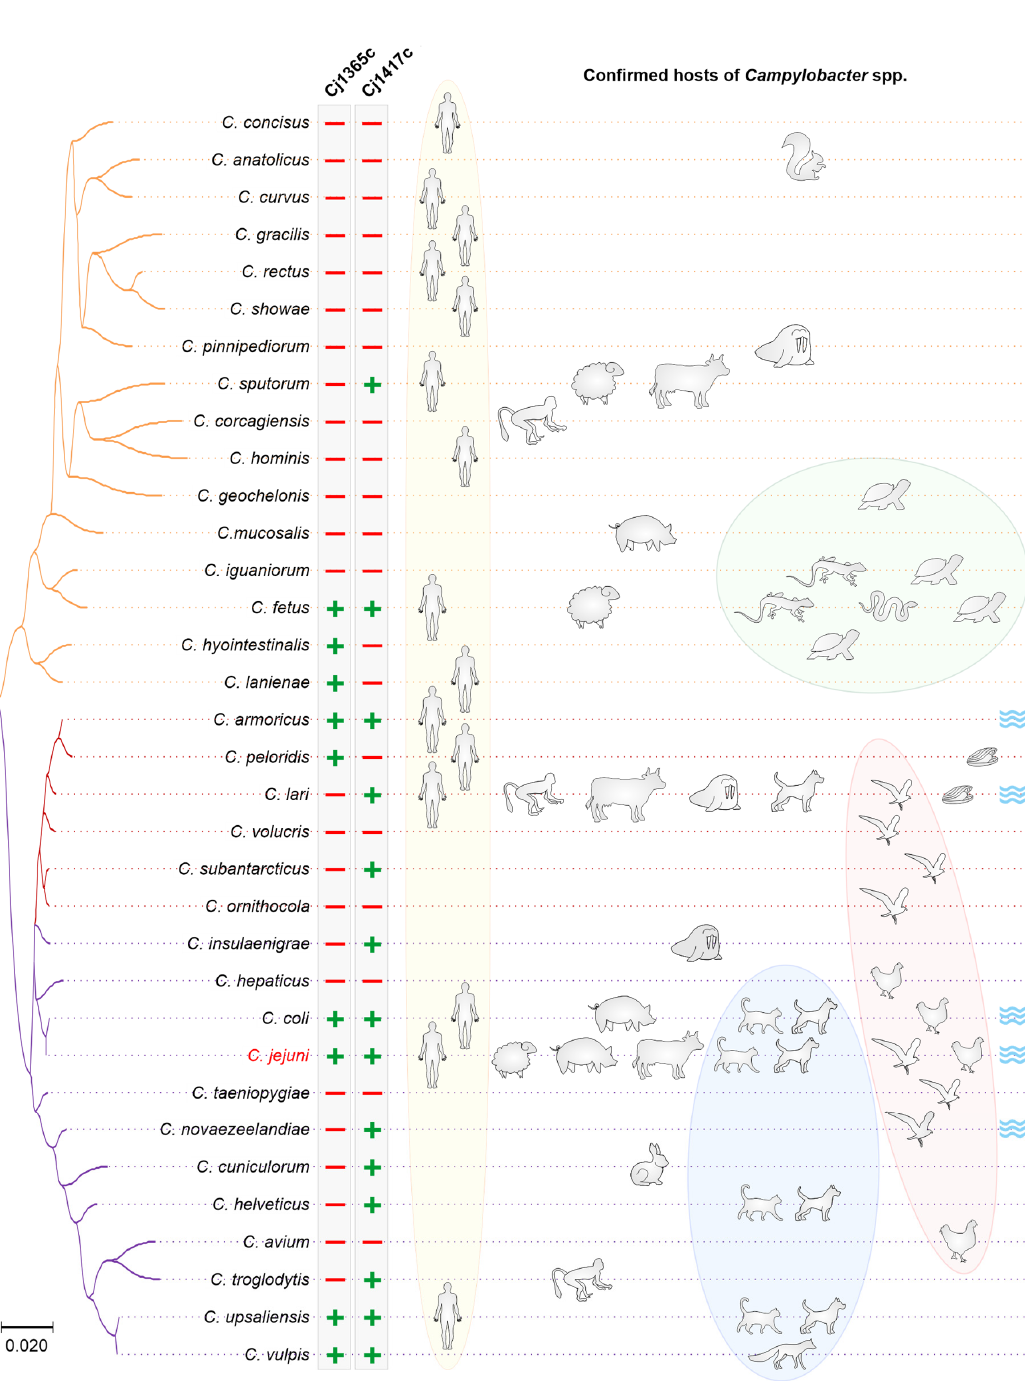
Figure 3. 16S rRNA-based Neighbor-joining tree of 34 Campylobacter species, and correspond- ing hosts. The color-coded tree branches indicate type I (purple) and type II (orange and brown) PepP variants as in Figure 1. Presence or absence of Cj1365c or Cj1417c (C26) proteases in the Campylobacter species is indicated by “plus” and “minus” symbols, respectively. Confirmed hu- man [113–128], monkey [115,129,130], sheep [117,120], pig [117,131–134], ruminant [115,117,120,135], marine mammal [115,136,137], poultry [113,117,138,139], cat/dog [113,115,118,140,141], fox [142], rabbit [143], squirrel [144], wild bird [115,145–150], reptile [151–154], and sea shell [116] hosts of Campylobacter spp., as well as water source [113,115,119,148], are shown on the right side by the corresponding symbols. Yellow, blue, red and green ellipses show the “human”, “cat/dog/fox”, “bird” and “reptile” host groups,